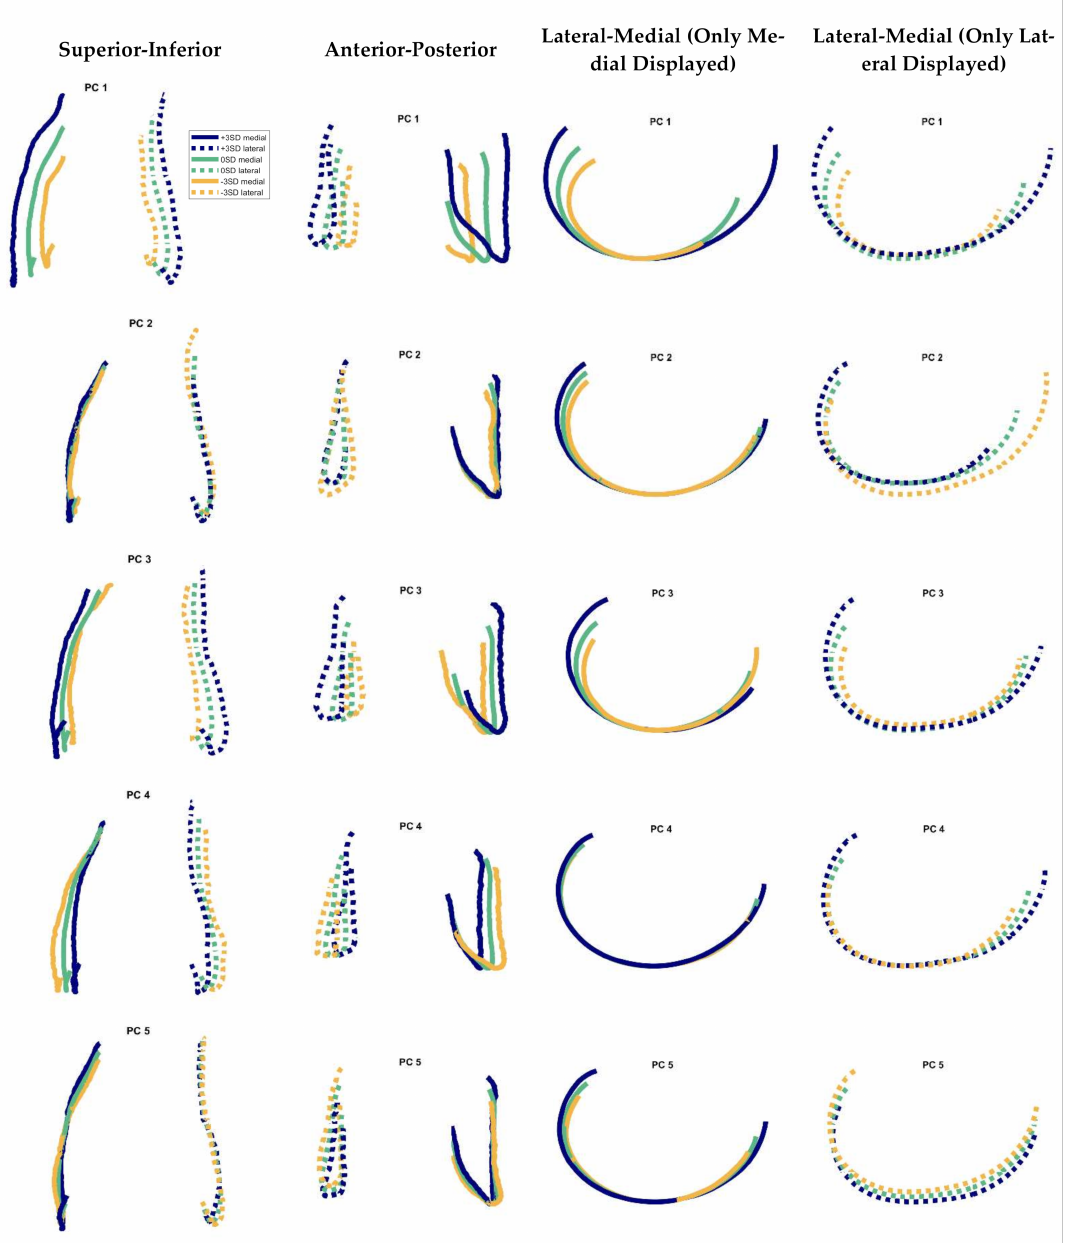
Figure 5. Modes 1–5 of the cadavers’ 3D J-Curves in different views. Solid line: medial, dashed line: lateral. 3SD = 3 standard deviations. All contours were oriented to their most distal point in proximodistal direction, for better comparison of the respective variance. Variation explained by the modes 1–5: 31.5, 23.4, 20.1, 7.4, and 5.5%,